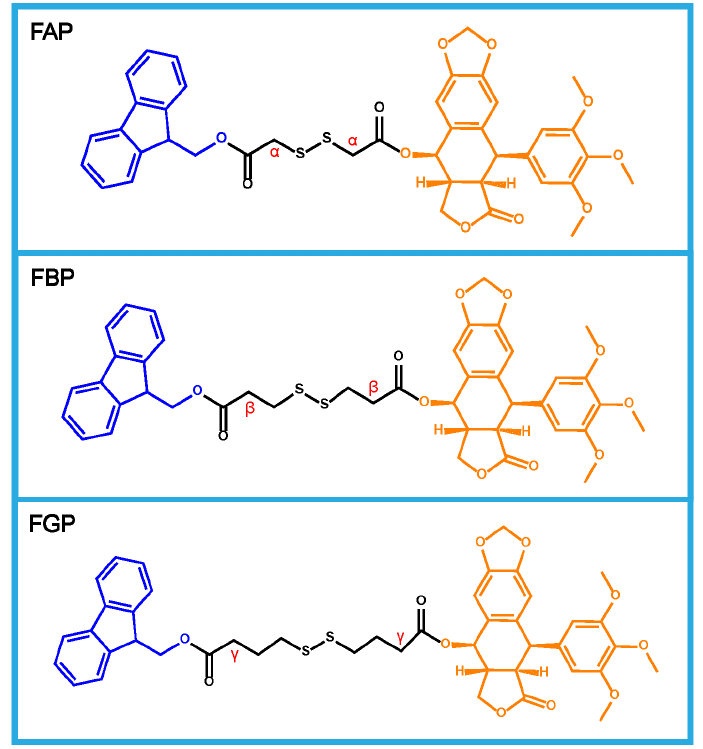
Chart 1. Chemical structures of the disulfide bond-bridged prodrugs: FAP, FBP and FGP.